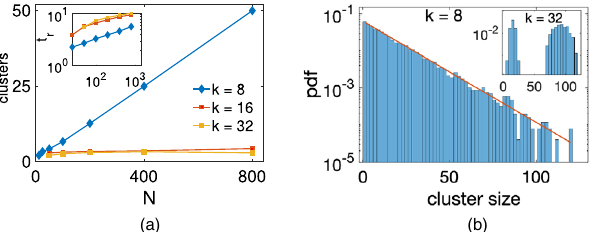
1 Figure 3. (a) Average number of clusters and average time to reach the balanced states, t r , with f = 8, 16, 32 . Results are averaged over 1000 runs on a regular ring network for (inset), as a function of N for K = 16 . (b) Probability density 800 with G 9 and Q 12, 25, 50, 100, 200, 400 and over 100 runs for N N = = = = 8 (main plot) and K 32 (inset). The red line indicates a linear fit on a semi- function of cluster sizes for K = = 16 . One observes an exponential (bimodal) distribution for K 200 , G 9 and Q 8 log scale. Here N = = = = 32 ) networks, ( K =